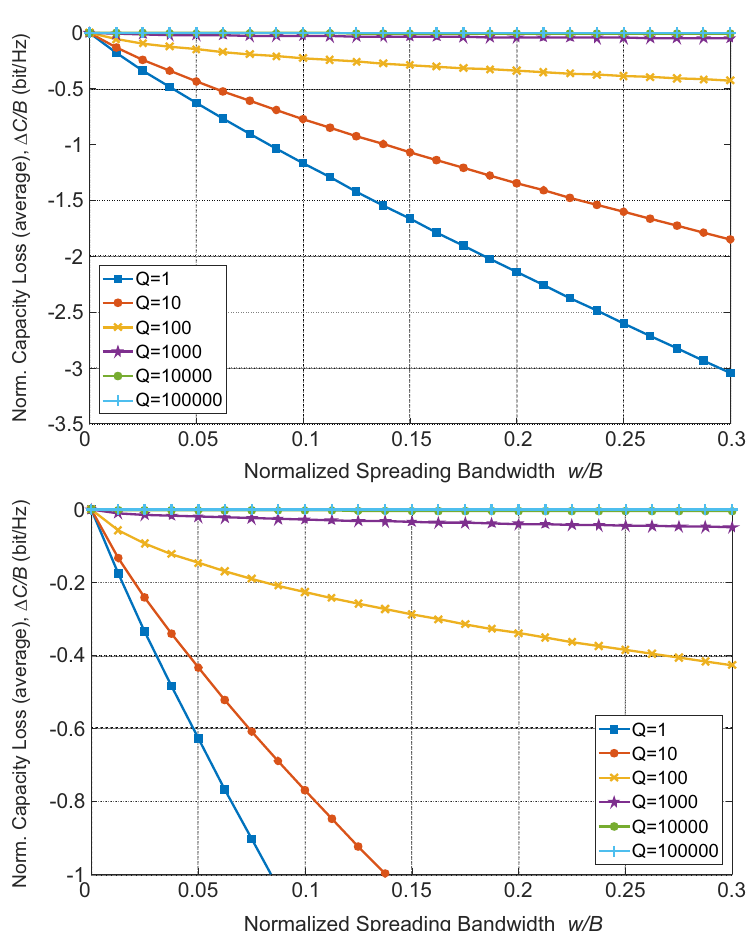
Figure 7. Average normalized capacity for resonant frequencies f R ranging from 2 B to 7 B versus SS-modulation depth δ ranging from 0 (no SS) to 30% for different values of the resonant coupling quality factor Q under constant peak coupling. A detail of the top figure is reported in the bottom